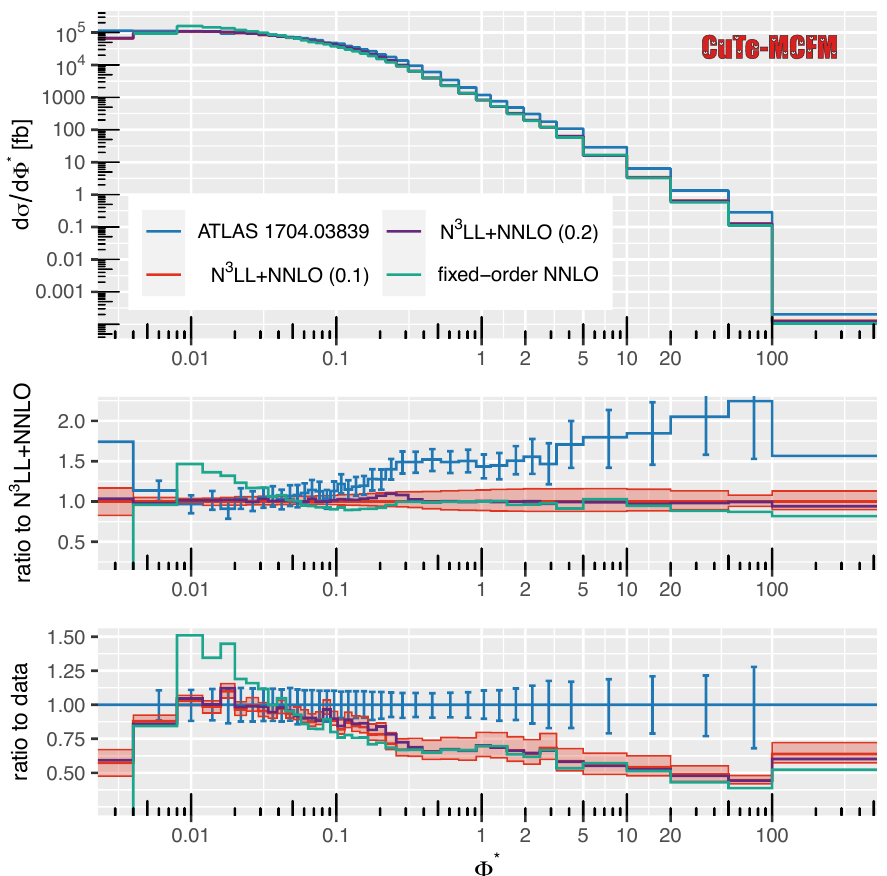
Figure 19. Comparison of the ATLAS measurement of the diphoton φ ∗ at 8 TeV with predictions at N 3 LL+NNLO including uncertainties associated with scale